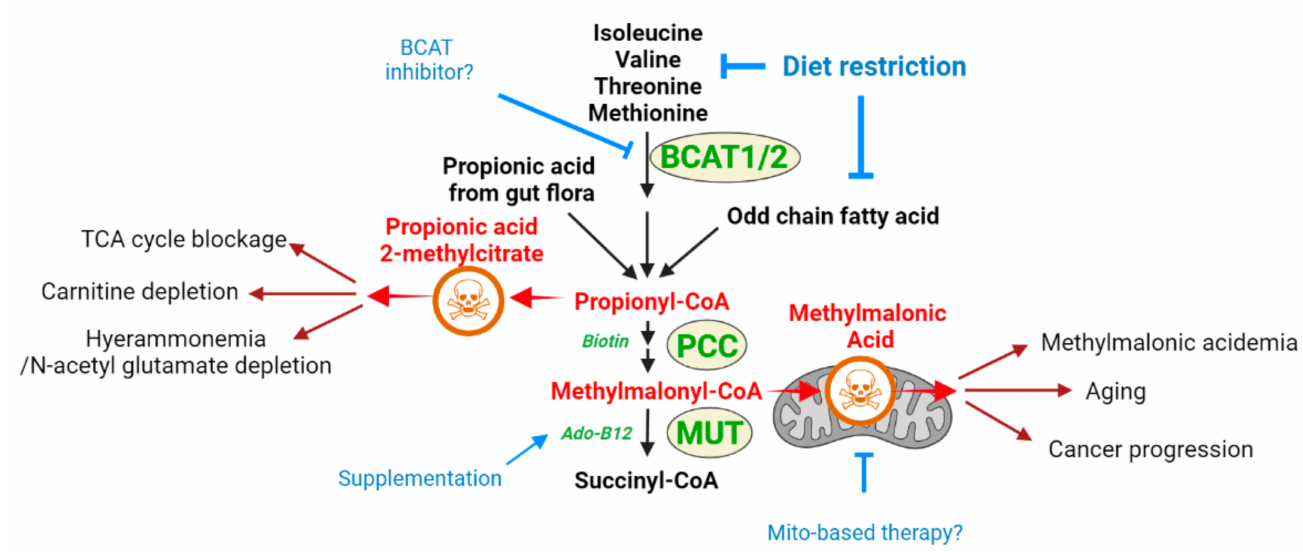
Figure 2. Schematic diagram of metabolic pathway containing toxic methylmalonyl-CoA and its toxicity mechanism and treatment options. In methylmalonic aciduria, branched-chain amino acids, fatty acids, or propionic acids produced by gut flora can feed into propionyl-CoA formation, lead- ing to methylmalonyl-CoA production. The loss of MUT activity via mutations to the enzyme itself or via mutations to enzymes required to produce the adenosylcobalamin cofactor leads to an accumulation of methylmalonic acid. Methylmalonic acid appears to cause mitochondrial tox- icity, and this mechanism may be at play in other disease contexts as well. Dietary restriction of branched-chain amino acids to restrict MMA production from above, or adenosylcobalamin supple- mentation to aid MUT activity, are current strategies. This diagram of MMA pathology suggests that a BCAT enzyme inhibitor, or therapies that aid mitochondrial function, may be considered as